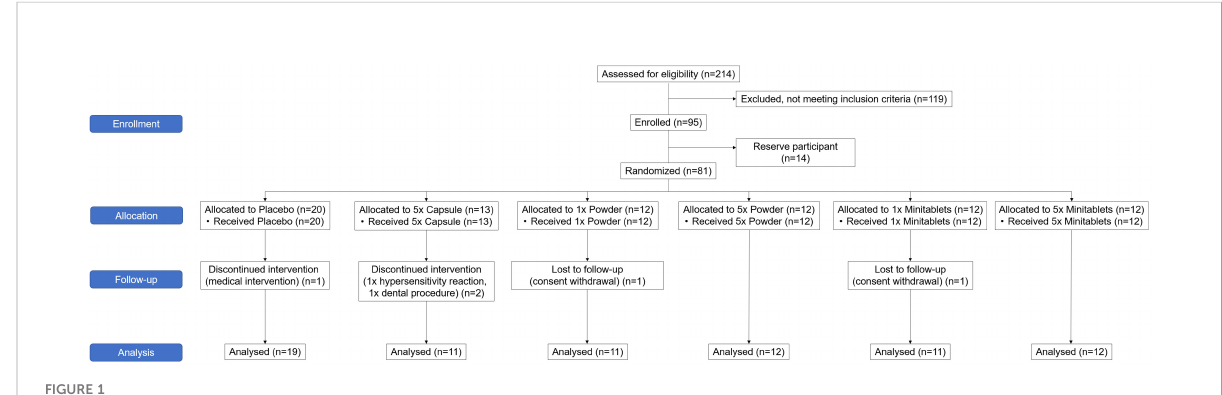
FIGURE 1 CONSORT 2010 fl ow diagram of the progress through the phases of the